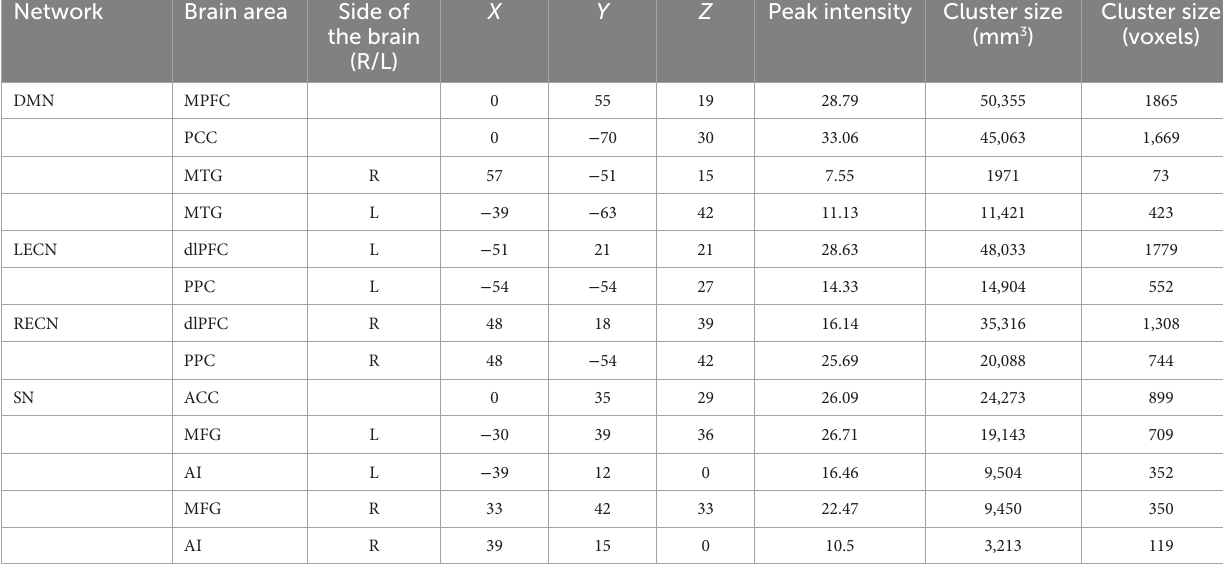
TABLE 1 Large-scale networks from the group independent component